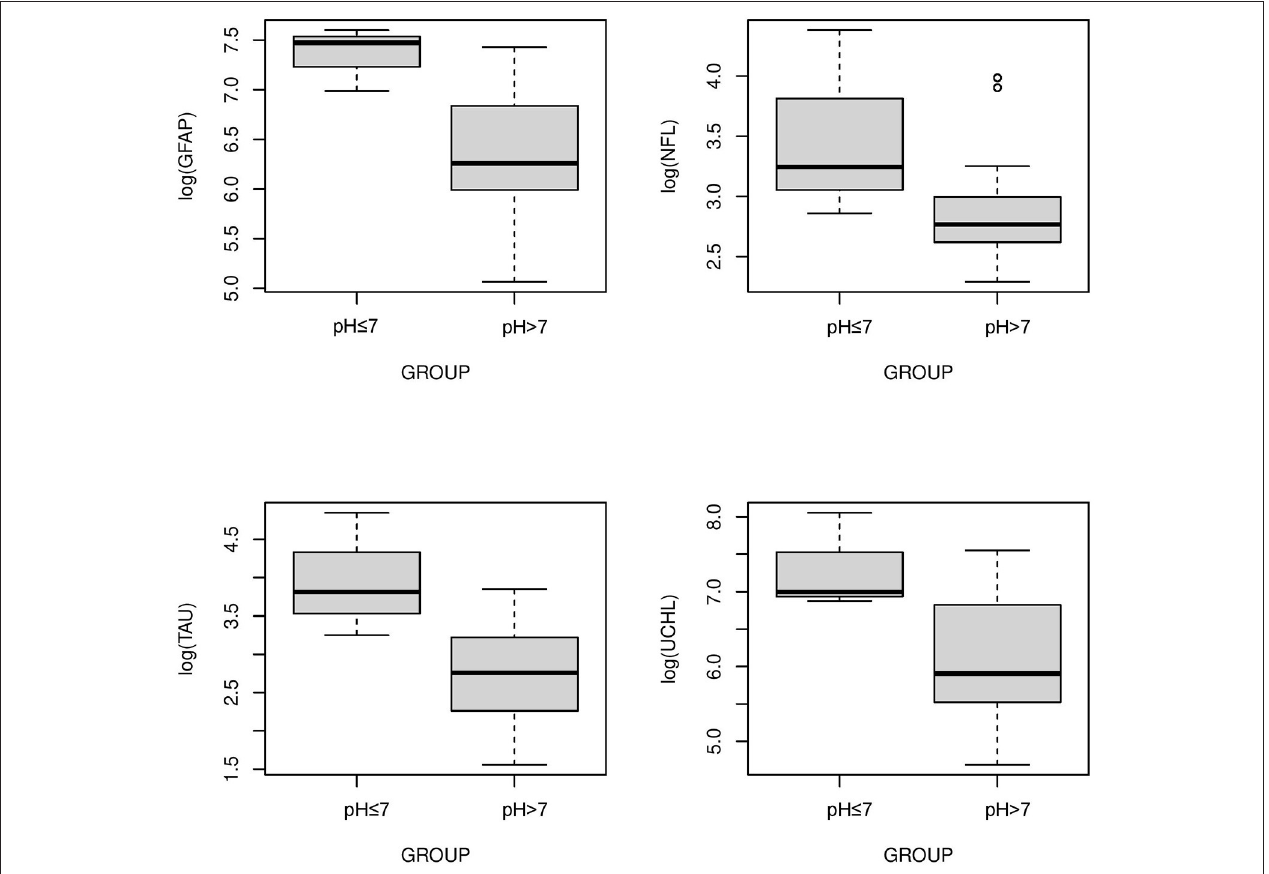
FIGURE 3 | Serum concentrations of GFAP, NFL, Tau, and UCH-L1 in neonates with a pH ≤ 7 compared to a pH > 7. GFAP, Tau and UCHL1 serum concentrations were higher in neonates with a pH ≤ 7 compared to neonates with a pH > 7 ( P < 0.05) (Mean ± STD). Serum concentration of NFL was similar between neonates with pH ≤ 7 and neonates with pH > 7